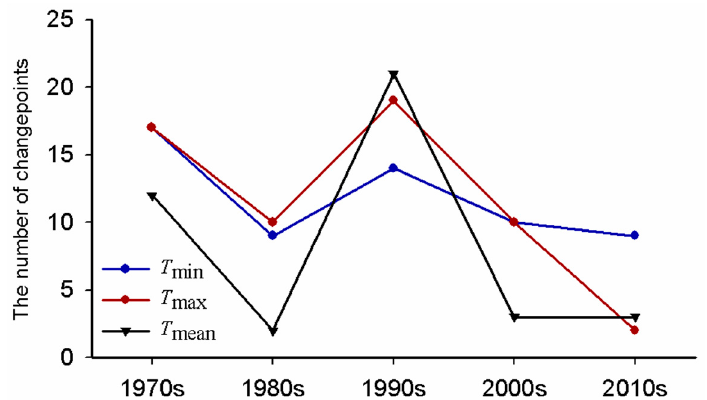
Figure 2. The number of changepoints in the monthly minimum temperature (T min ), the monthly maximum temperature (T max ) and the monthly mean temperature (T mean ) dataseries during different periods.